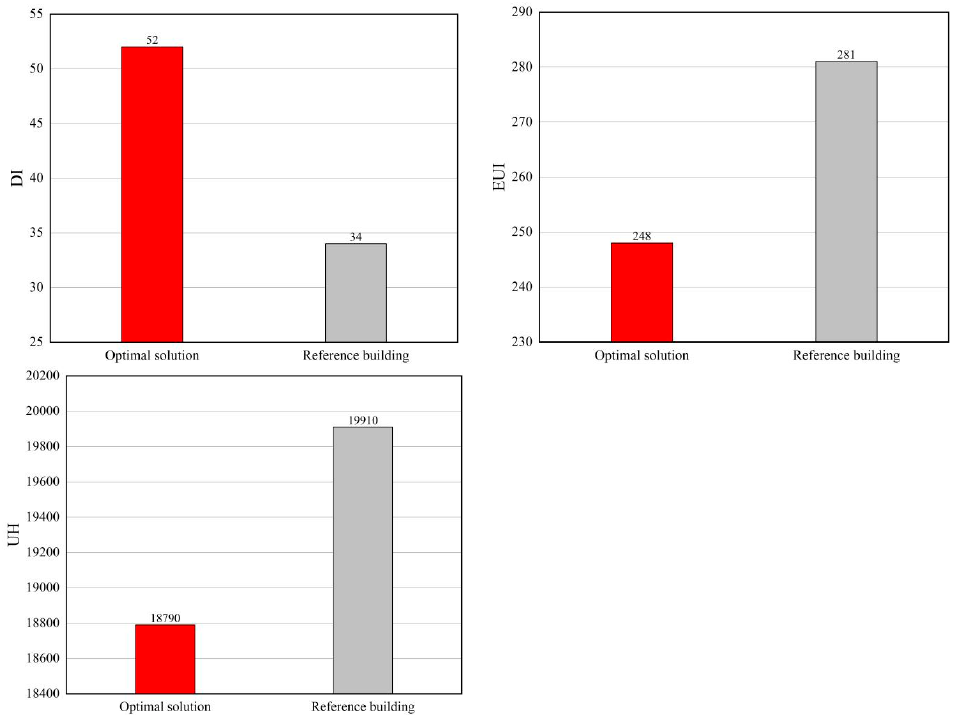
Figure 9. Performance comparison between optimization solution and reference building. Table 4. Clustering result of non-dominated solutions.